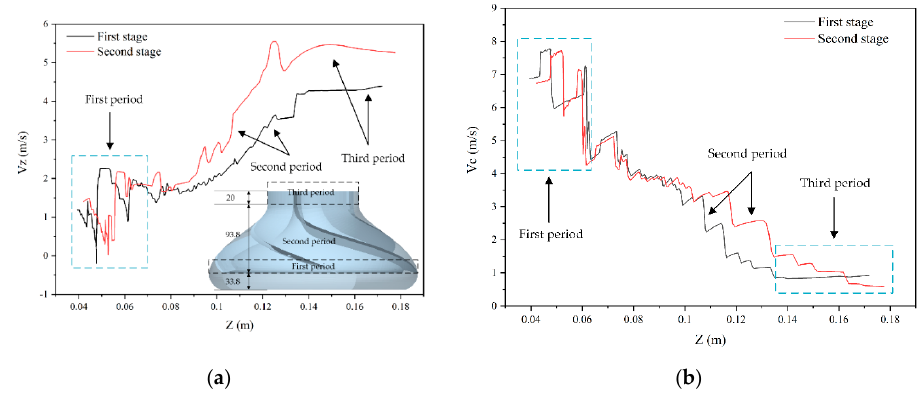
Figure 17. There are differences between different particles, and the dotted box only indicates the approximate location: ( a ) axial velocity 𝑉 (cid:3053) of particles in the bowl diffuser; ( b ) circumferential velocity 𝑉 (cid:3030) of particles in the bowl diffuser.